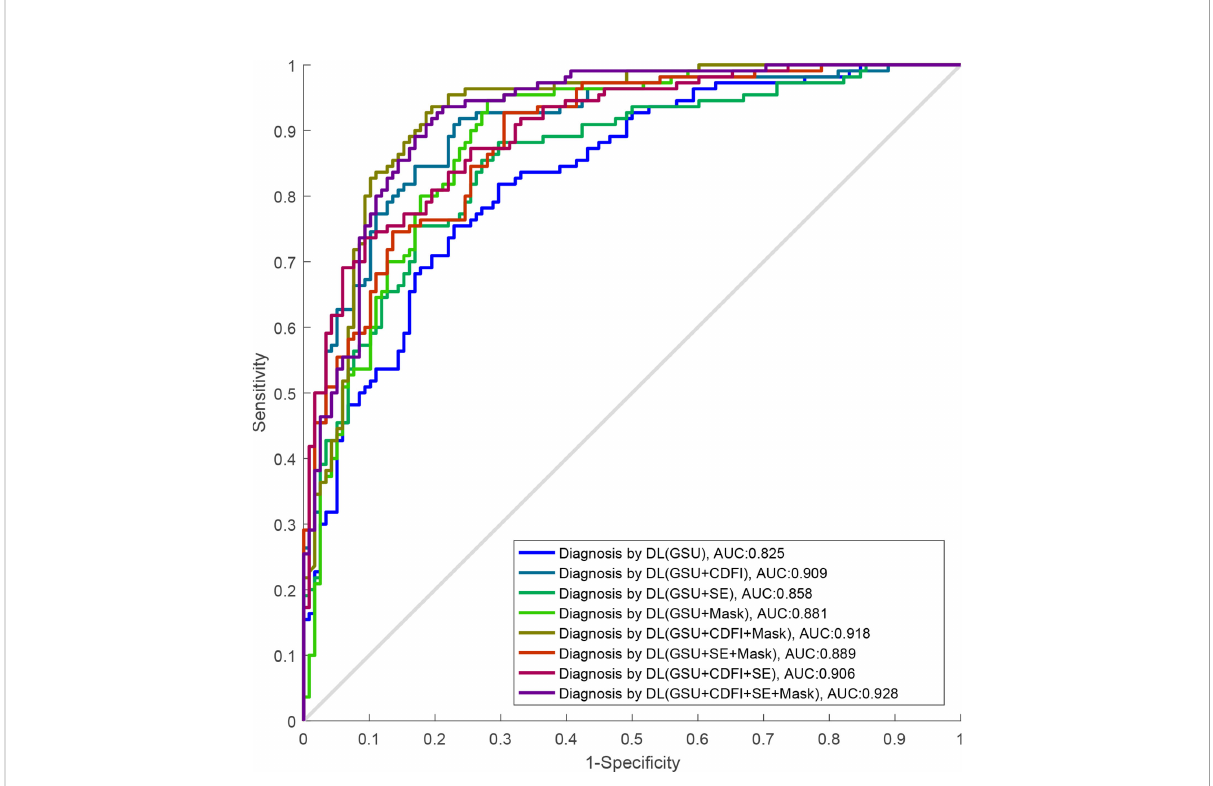
FIGURE 5 The ROC curves of DL-based single GSU and multimodality. ROC, receiver operating characteristics; DL, deep learning; GSU, gray-scale